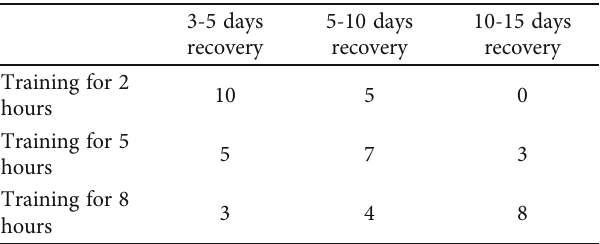
Table 3: Pro fi ciency of the original action (%). Table 2: Training intensity and ankle